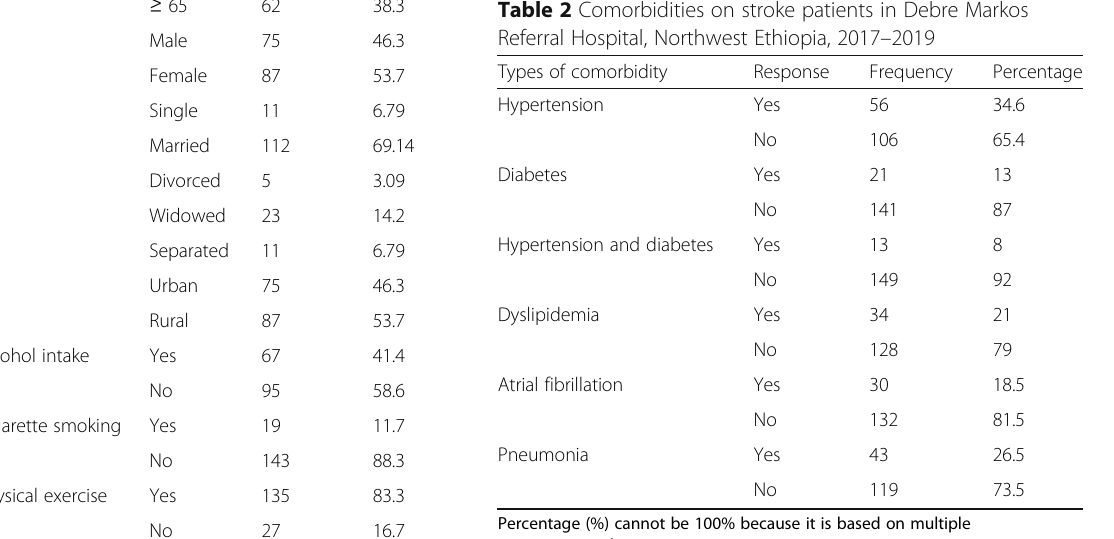
Table 2 Comorbidities on stroke patients in Debre